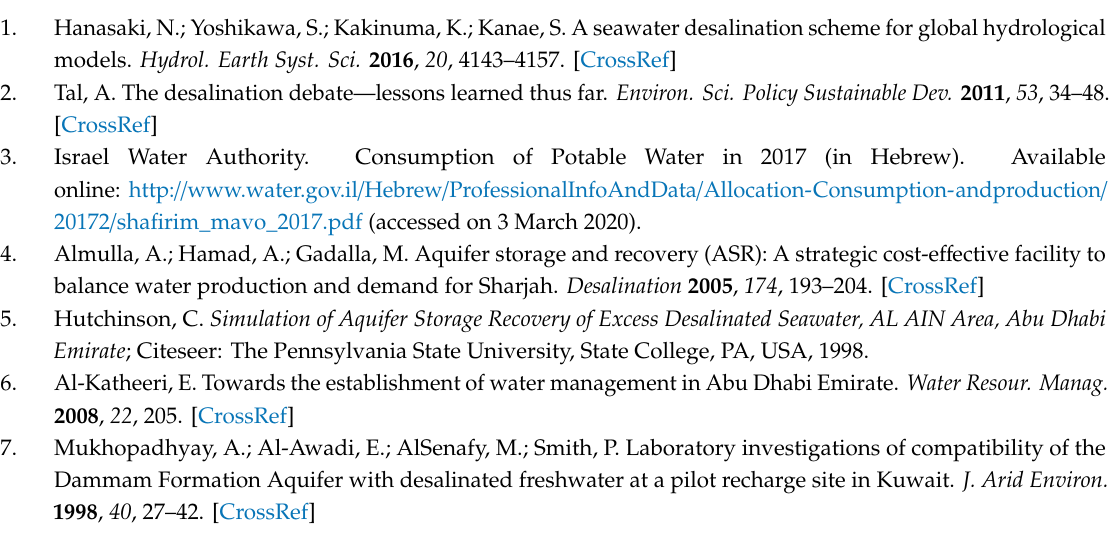
Table S1: THM concentrations in a small-scale field experiment, untreated DSW (29th April 2018); Table S2: THM concentrations in a small-scale field experiment, bromide spiked DSW (1st May 2018); Table S3: Bromide concentrations in a small-scale field experiment, untreated DSW (29th April 2018); Table S4: Bromide concentrations in a small-scale field experiment, bromide spiked DSW (1st May 2018); Table S5: THM concentrations in a large-scale infiltration event, day 8 (15th January 2018); Table S6: THM concentrations in a large-scale infiltration event, day 17 (24th January 2018); Table S7: THM concentrations in a large-scale infiltration event, day 24 (31 January